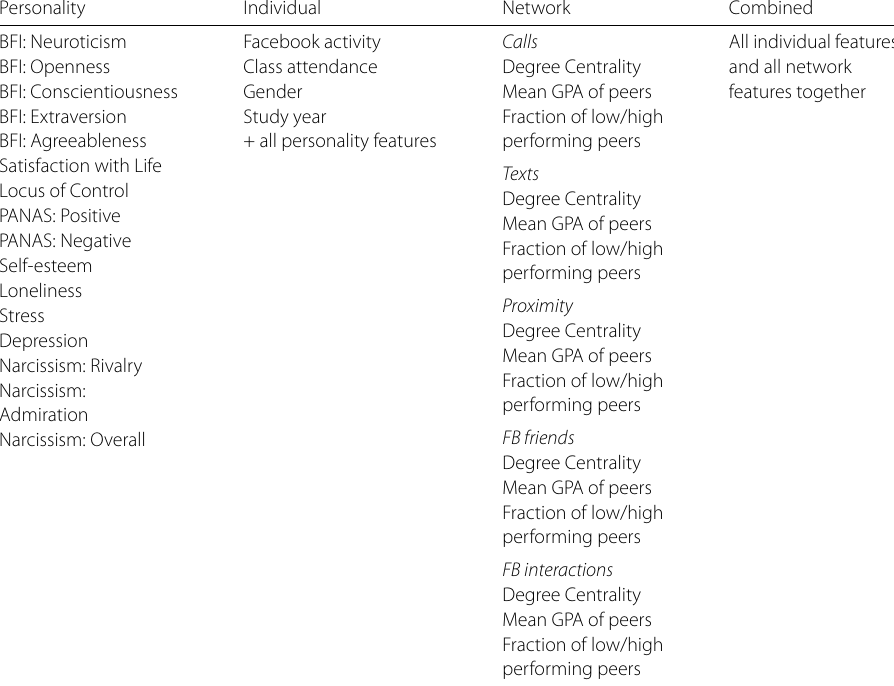
Table 1 Feature sets for data-driven modeling Personality Individual Network Combined